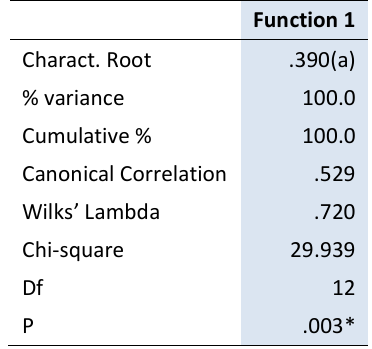
Table 8: Group centroids on the discriminant